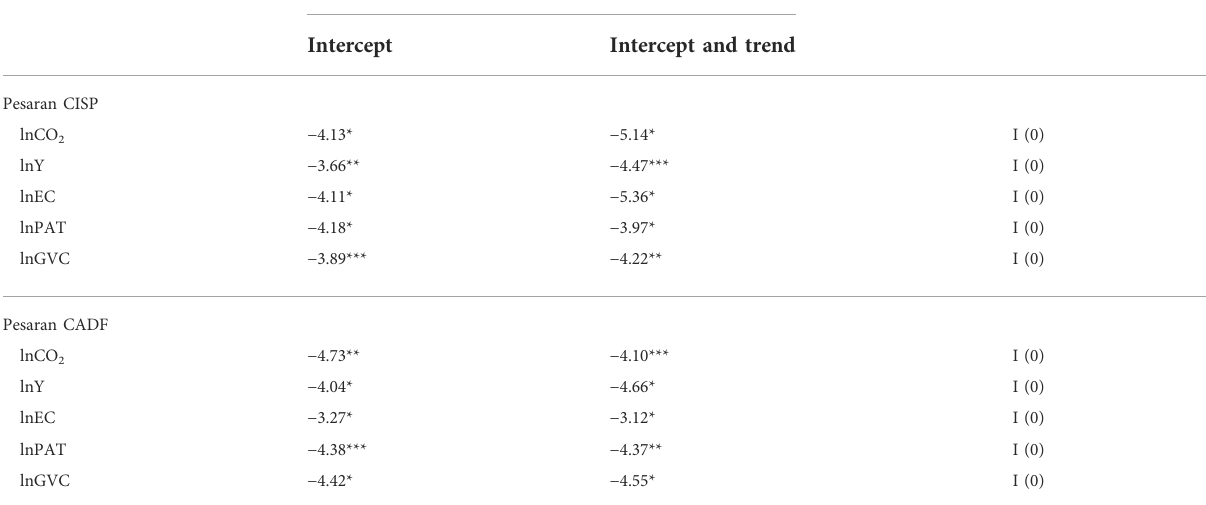
TABLE 4 Pesaran ’ s (2007) unit root test